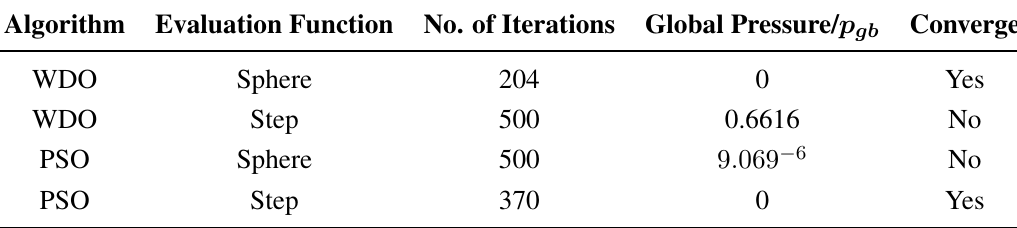
Table 3. Convergence comparison of the WDO and PSO